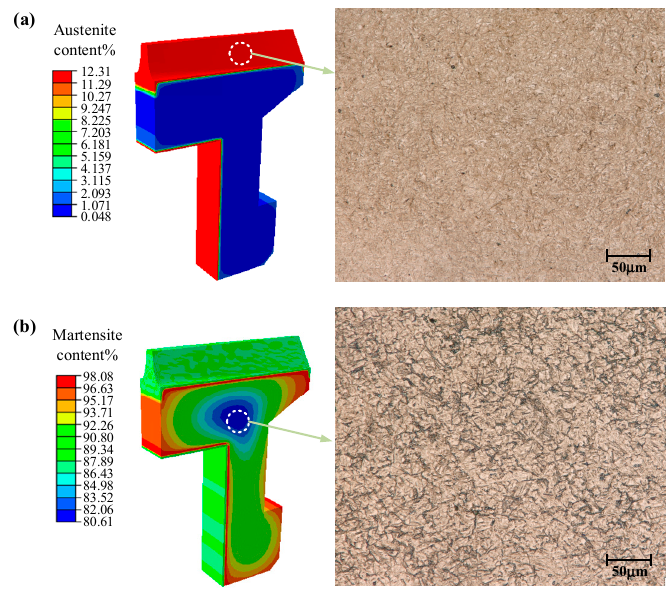
Figure 10. Distribution of metallographic structure for the face gear after the quenching process: ( a ) Austenite; ( b ) Martensite.